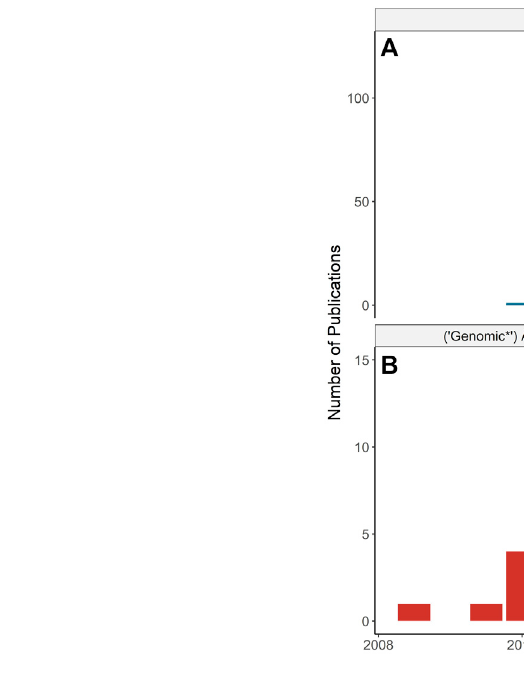
Frontiers in Genetics |